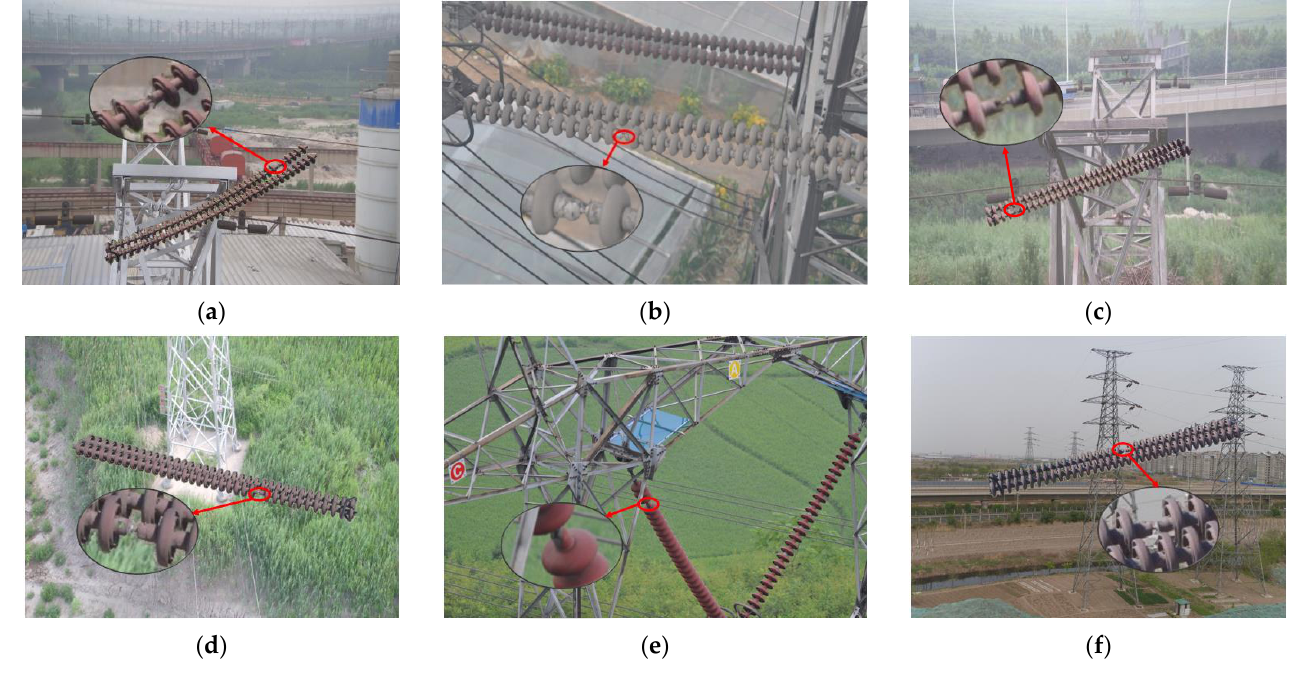
Figure 7. Images ( a – f ) show the defect of insulators